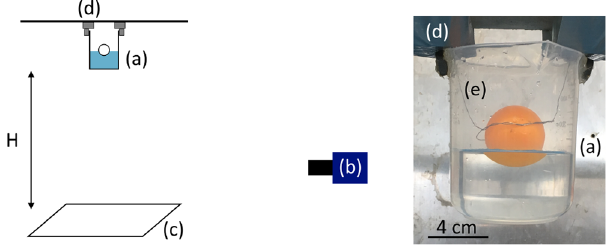
Fig. 2. Left: Schematic of the experimental setup. Right: close- up picture of the water-filled beaker with the ping-pong ball. (a) transparent beaker, (b) high-speed camera, (c) metal plate, (d) electromagnets, (e) metal wire.